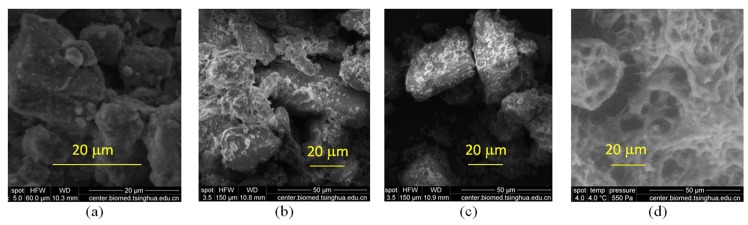
Environmental scanning electron microscopy photos of sediment samples after 15 days of biofilm growth.(a) Environmental mode, (b) high vacuum mode using the dried sample after environmental mode, (c) high vacuum mode using the clean sediment, (d) foam, which developed on the water surface during cultivation.